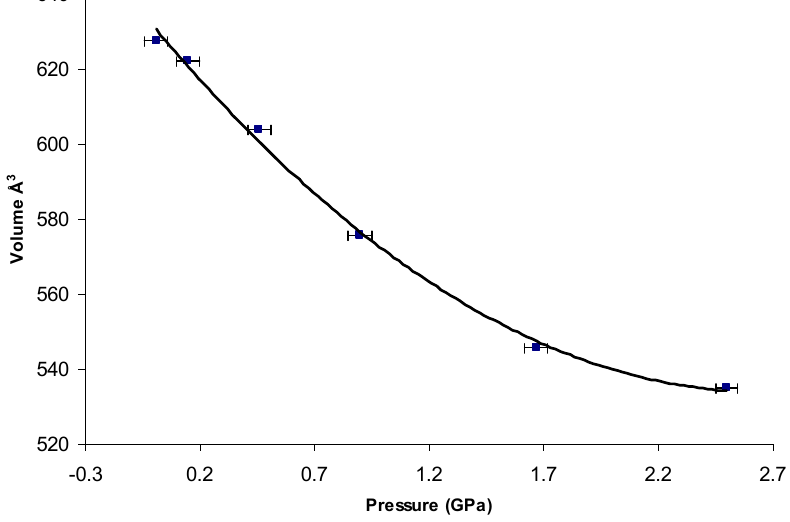
Figure 1. Variation of the unit cell volume of Form I with pressure.